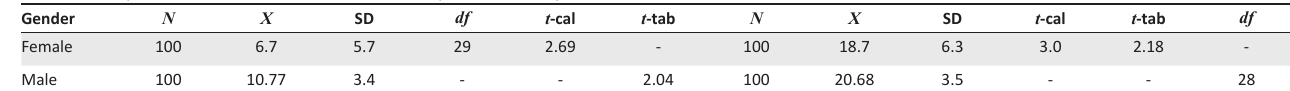
TABLE 3: Comparison of the female and male mean responses for